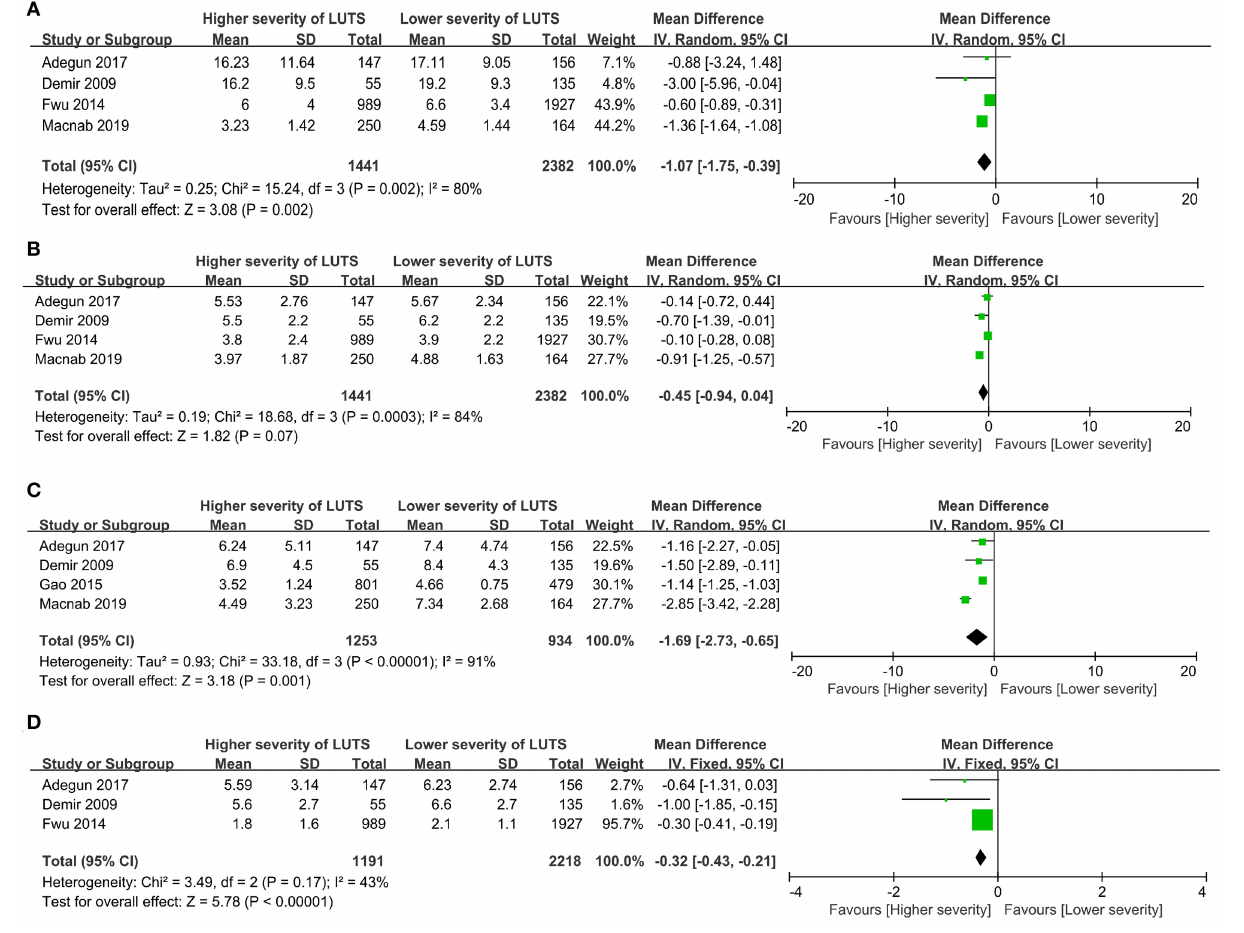
FIGURE 4 | Forest plots showing meta-analysis results of the association between LUTS severity and the sexual dysfunction domains using Sexual dysfunction assessment tools. (A) Erectile function, (B) Sexual desire, (C) Intercourse satisfaction and (D) Overall satisfaction. LUTS, lower urinary tract symptoms; CI, confidence interval; SD, standard